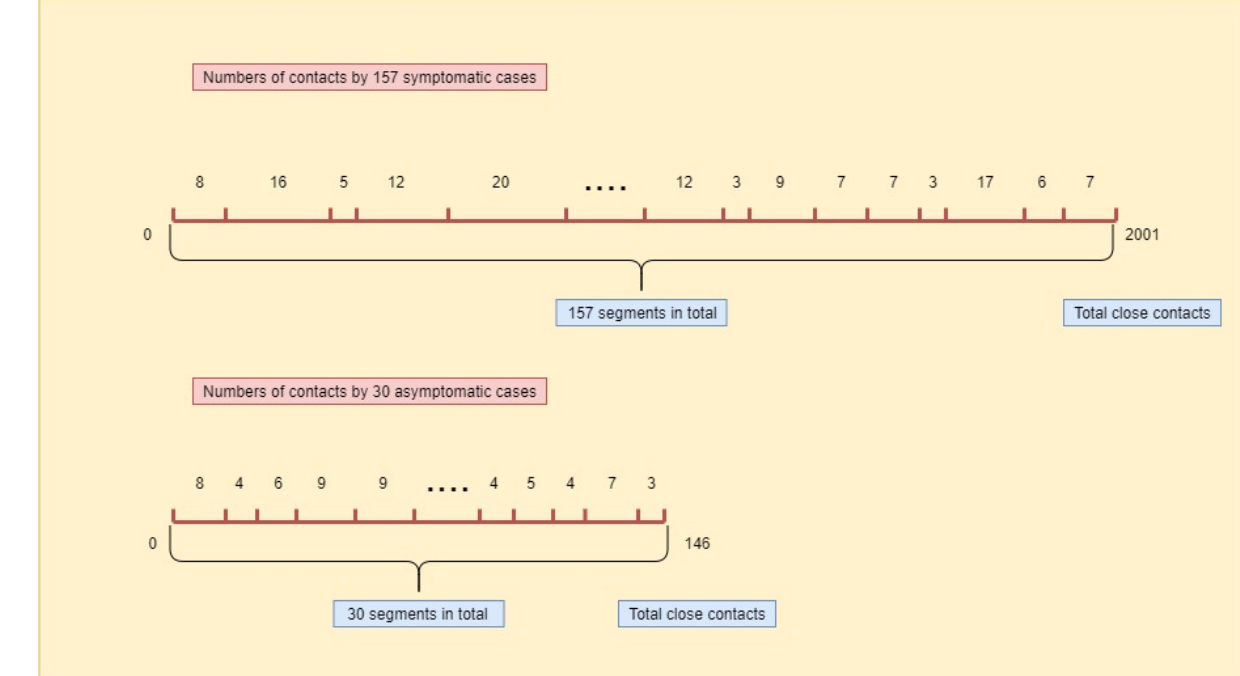
Figure 1. The diagram for the resampling step in the permutation test, where the lengths of segments are randomly generated corresponding to the number of close contacts for each individual